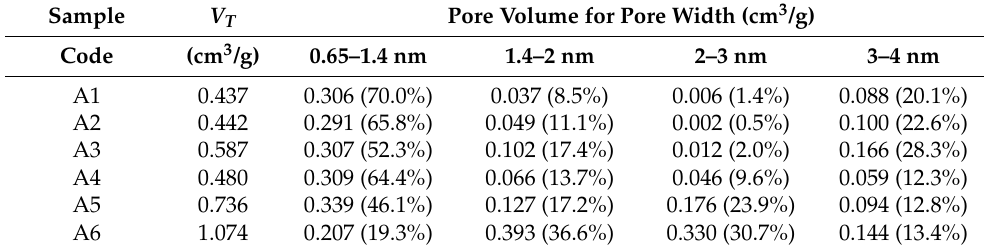
Table 3. Pore size distribution of prepared activated carbons.